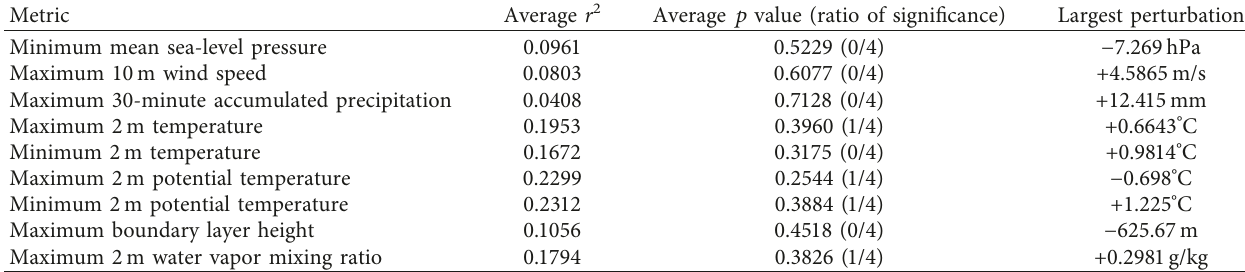
Table 4: Average coefficient of determination ( r 2 ), average p value with the ratio of significant cases (95% confidence), and largest perturbation to cyclone among tropical